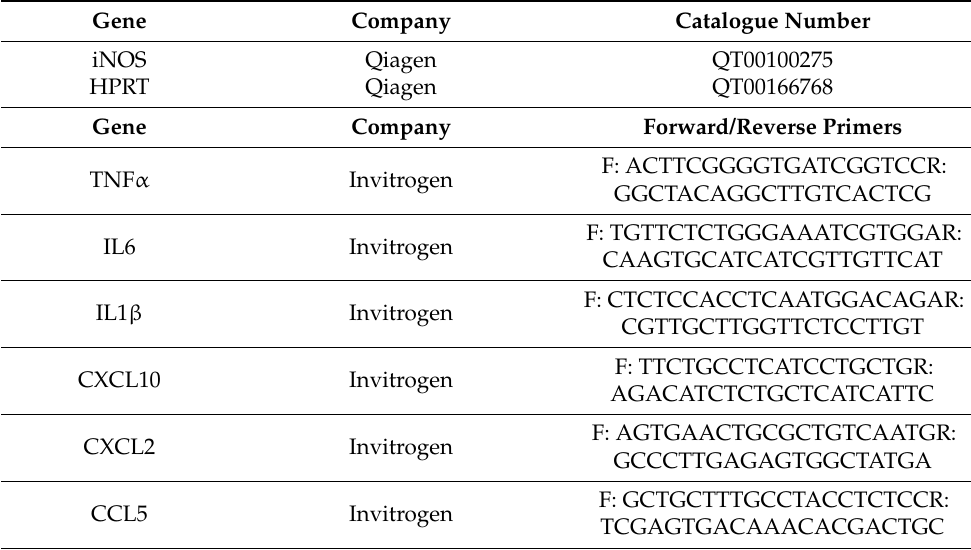
Table 2. Primers used for qPCR experiments during the present